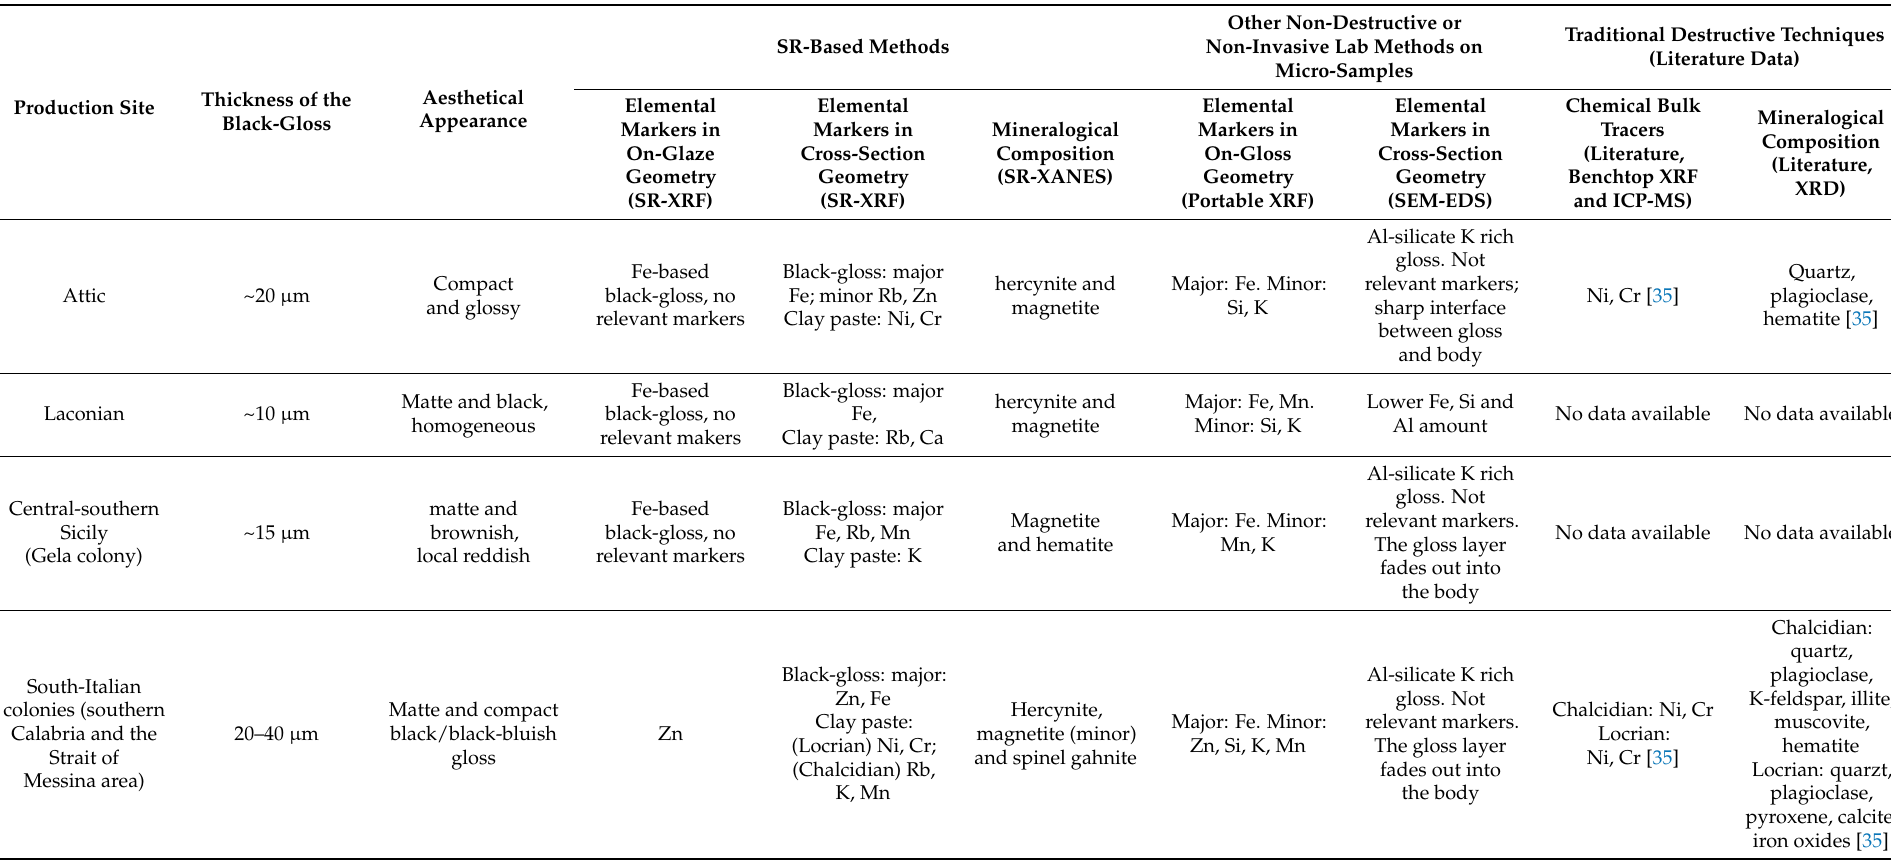
Table 3. Comparative evaluation on black gloss features (visual appearance, elemental and mineralogical markers) got from different methods (traditional vs. non-destructive and non-invasive techniques)